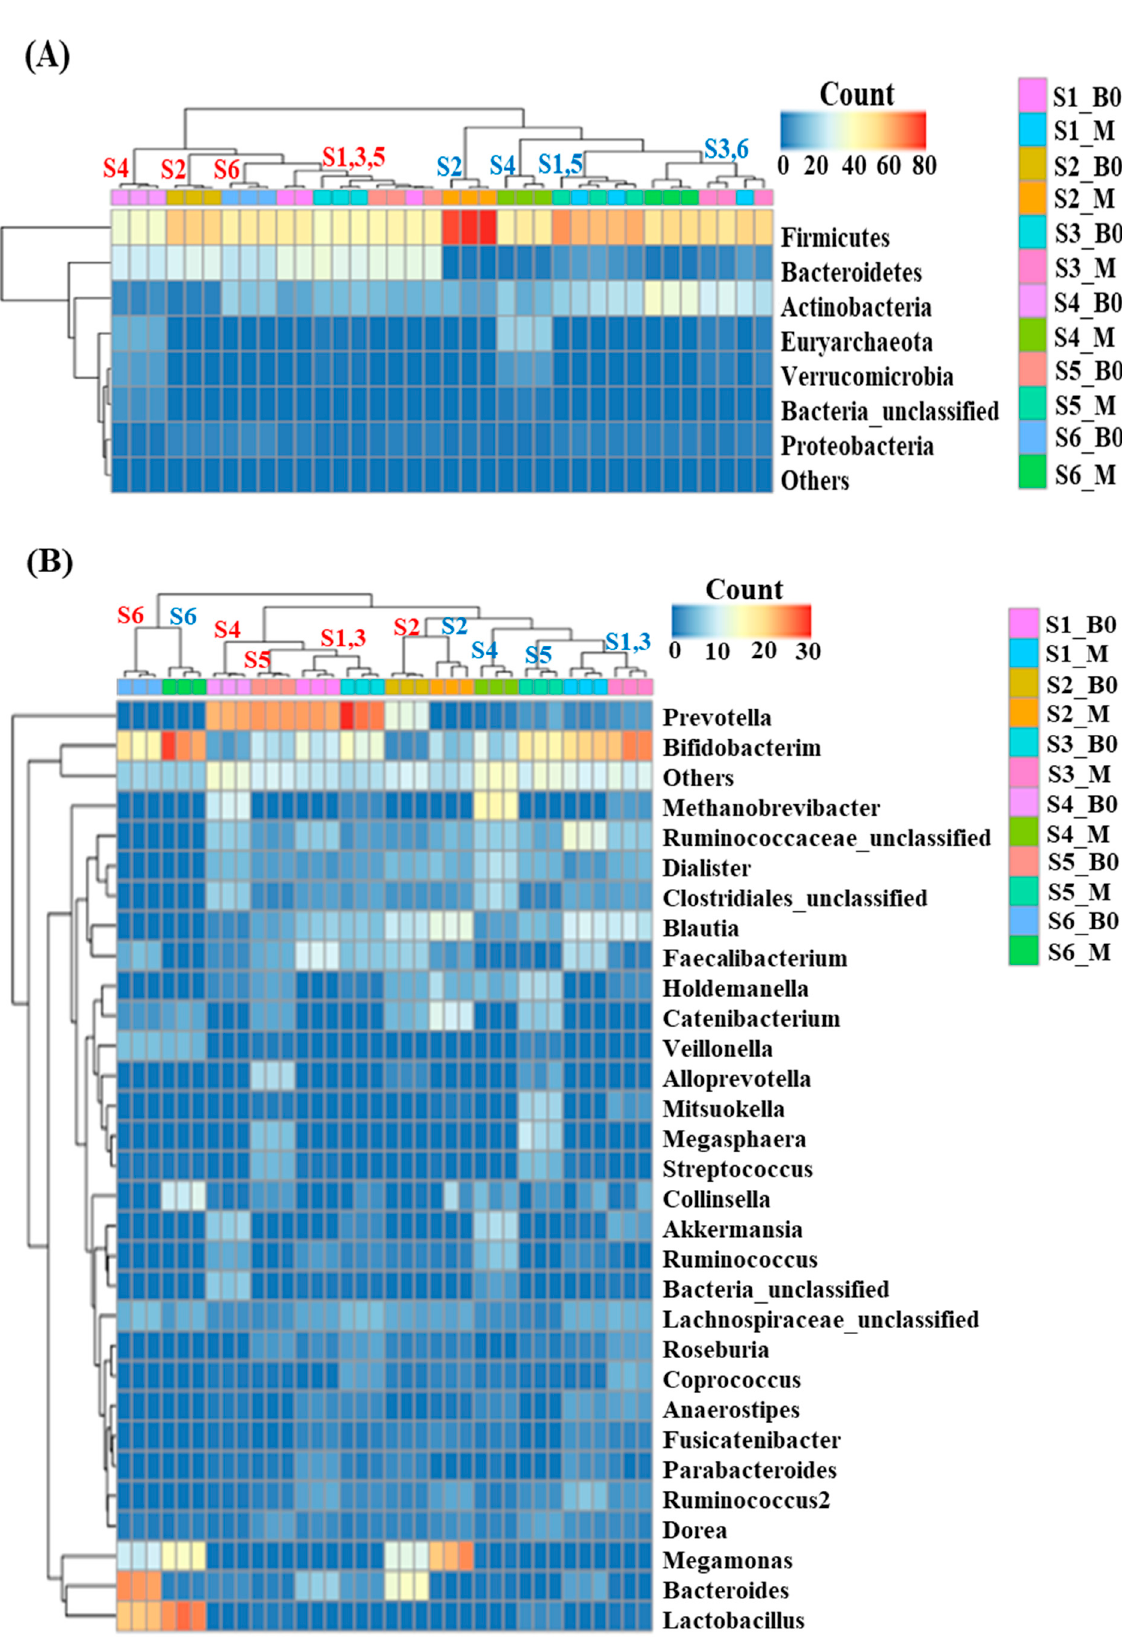
Figure 3. Beef-induced shift in microbial taxonomic composition at the phylum ( A ) and genus level ( B ), where red and blue letters indicate subjects with and without the beef treatment, respectively.